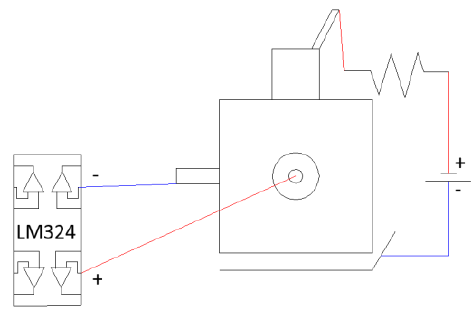
Figure 2. Wiring diagram of the implemented system. An electrode is fixed to the free side of the specimen on a plane perpendicular to that of the embedded bar.